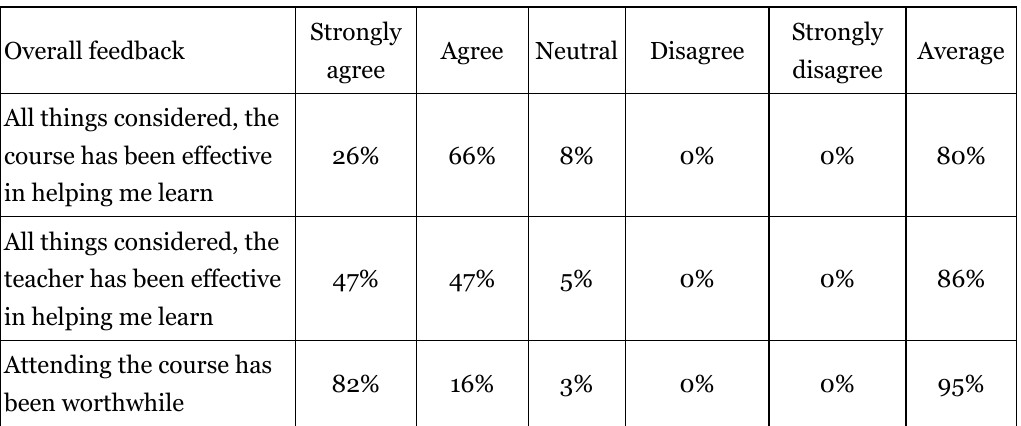
Overall Feedback on Course